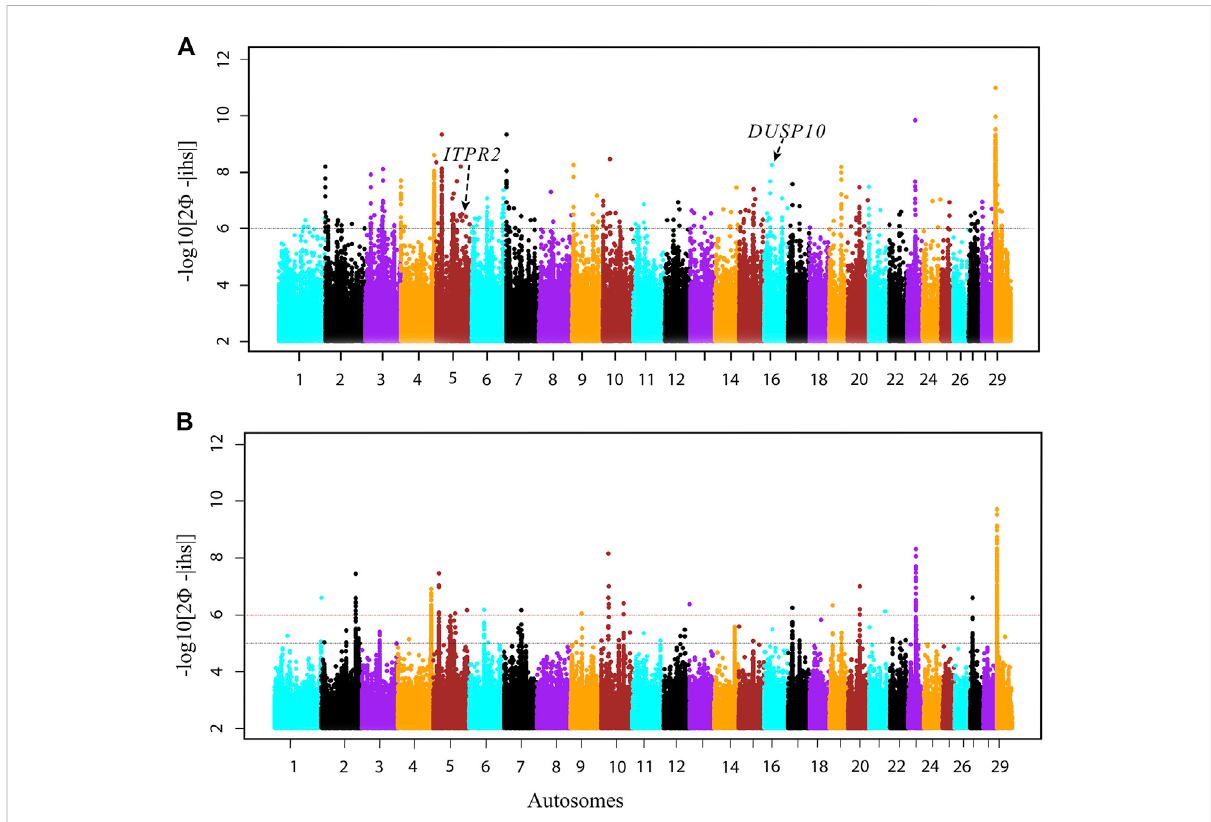
FIGURE 4 Manhattan plots of genome-wide scans based on the iHS test. (A) HA, high-altitude and (B) LA, low-altitude Ethiopian cattle populations.